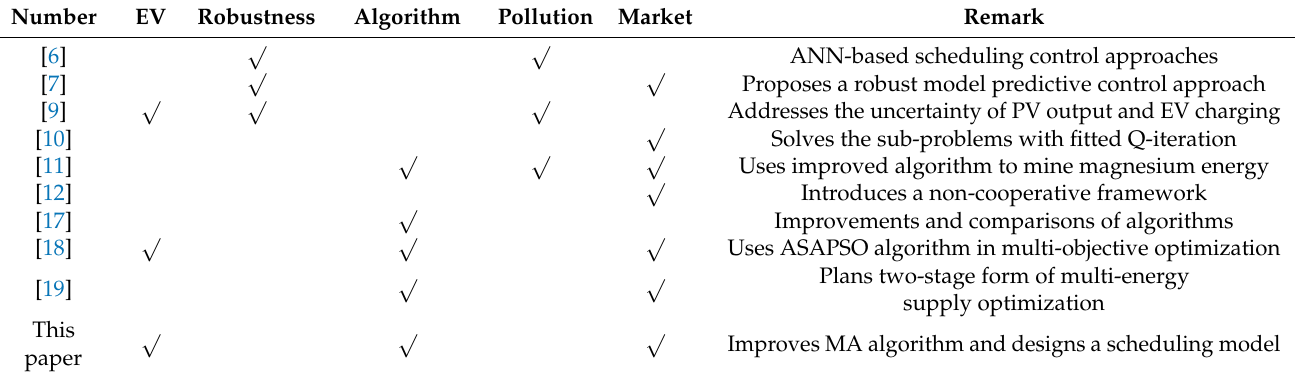
Table 1. Comparison of relevant